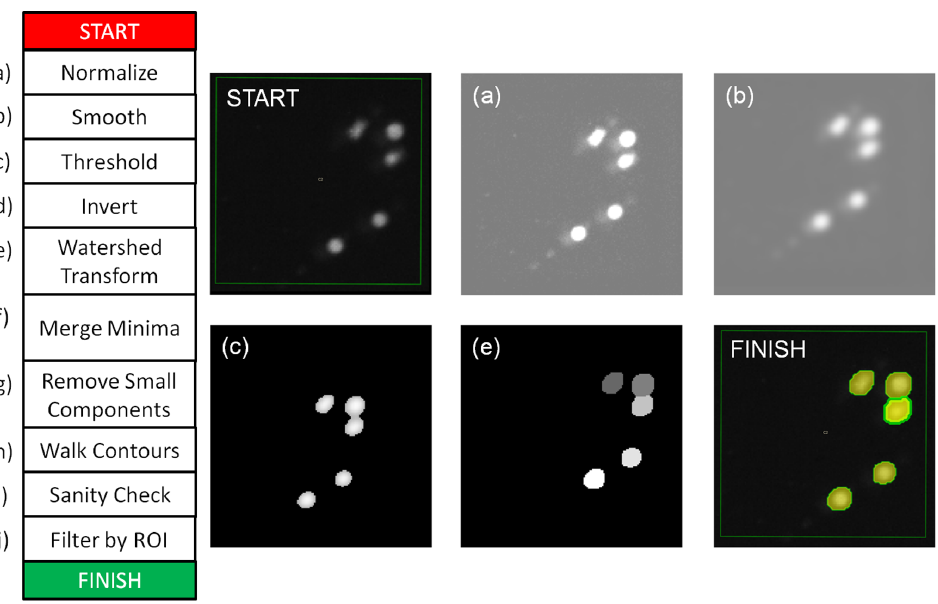
Figure 8. Process for automatic detection and segmentation of GFP cells that constantly fluoresce. This figure is provided to give the reader a more detailed understanding of the steps involved. The image labelled ‘‘START’’ shows 5 cells in a single microwell, with the user-defined Region Of Interest (ROI) shown as a green box. The images are normalized (a), smoothed (b) and thresholded (c) at a fixed intensity level. Intensity levels above the threshold are preserved, allowing the Watershed algorithm and connected-component analysis to label pixels associated with each individual cell (labels shown in image (e)). The Watershed step is necessary to segment cells that are touching. The remaining steps (f–g) try to control over or under-segmentation. The sanity check (i) exists to detect bad images due to acquisition faults. Bad (white noise) images produce an implausible number of detections and are then skipped. The final segmented contours are shown in (‘‘FINISH’’), with one cell selected.